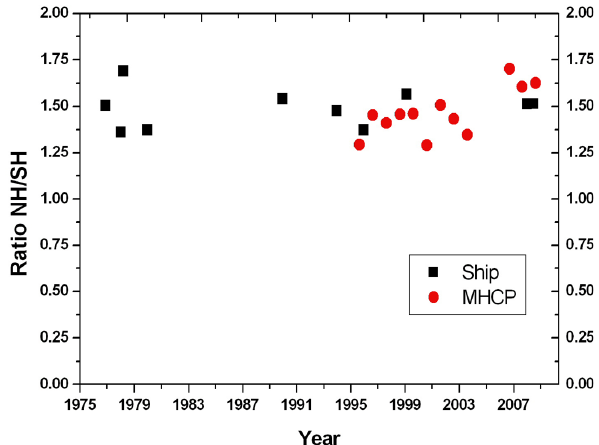
Fig. 2. Ratios of northern to southern hemispheric median concen- trations measured over the Atlantic Ocean since 1977 and ratios of annual median concentrations at Mace Head to those at Cape